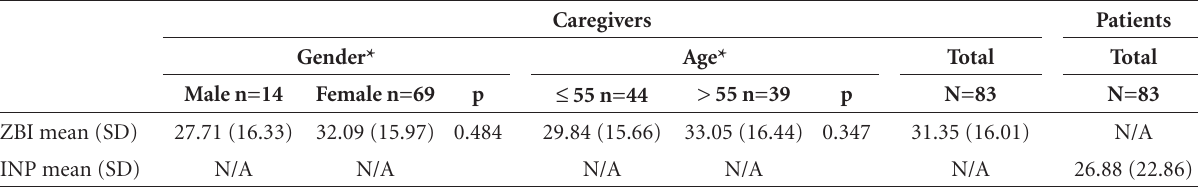
Table 2. ZBI and INP score